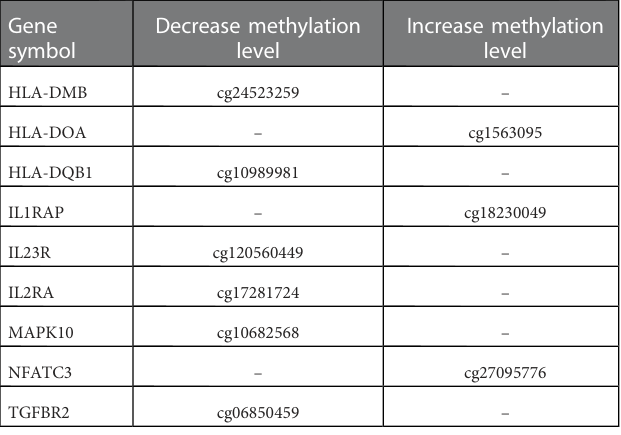
TABLE 2 Cpgs sites in genes related to Th17 cell differentiation pathway changed with exercise